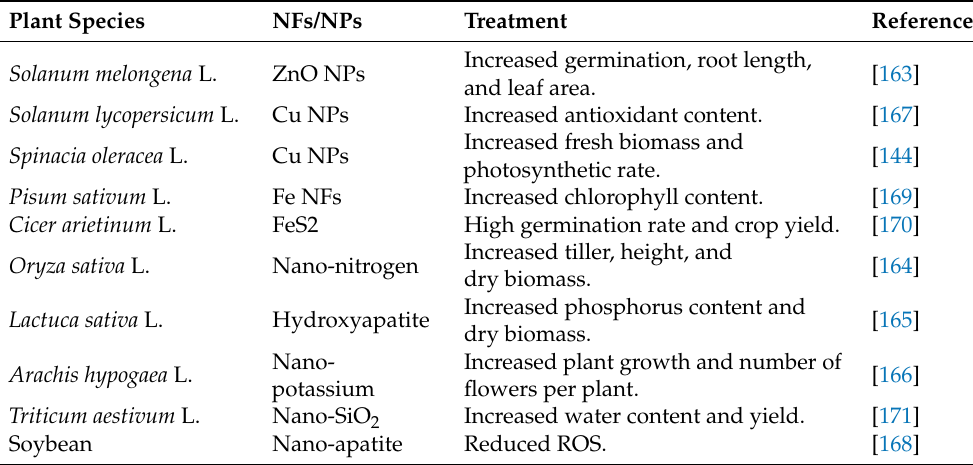
Table 4. Effect of different NFs and NPs on different